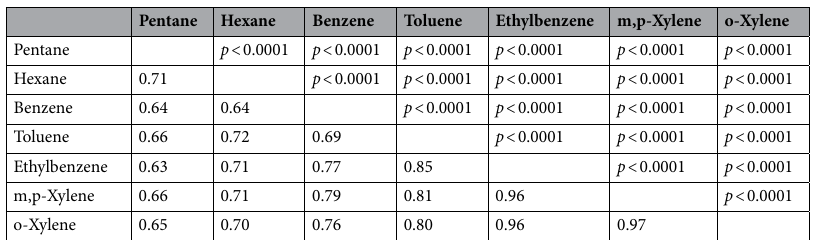
Table 5. Correlations (Spearman’s r, lower left) among indoor air concentrations of pentane, hexane, benzene, toluene, ethylbenzene, and the xylenes. All correlations were significant ( p values upper right).